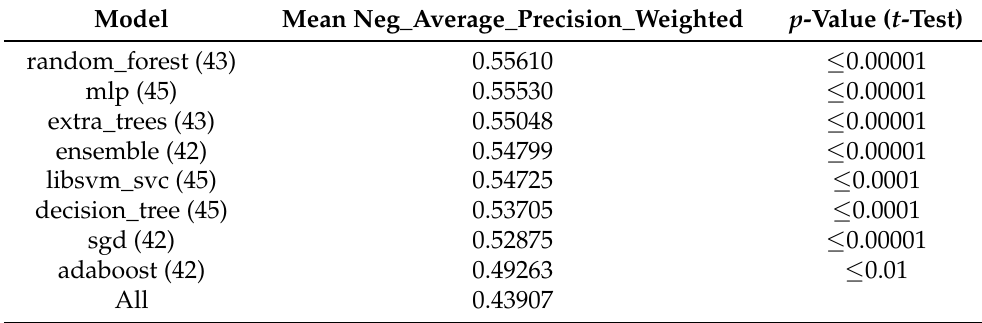
Table A6. Models with significantly better mean negative average precision weighted.